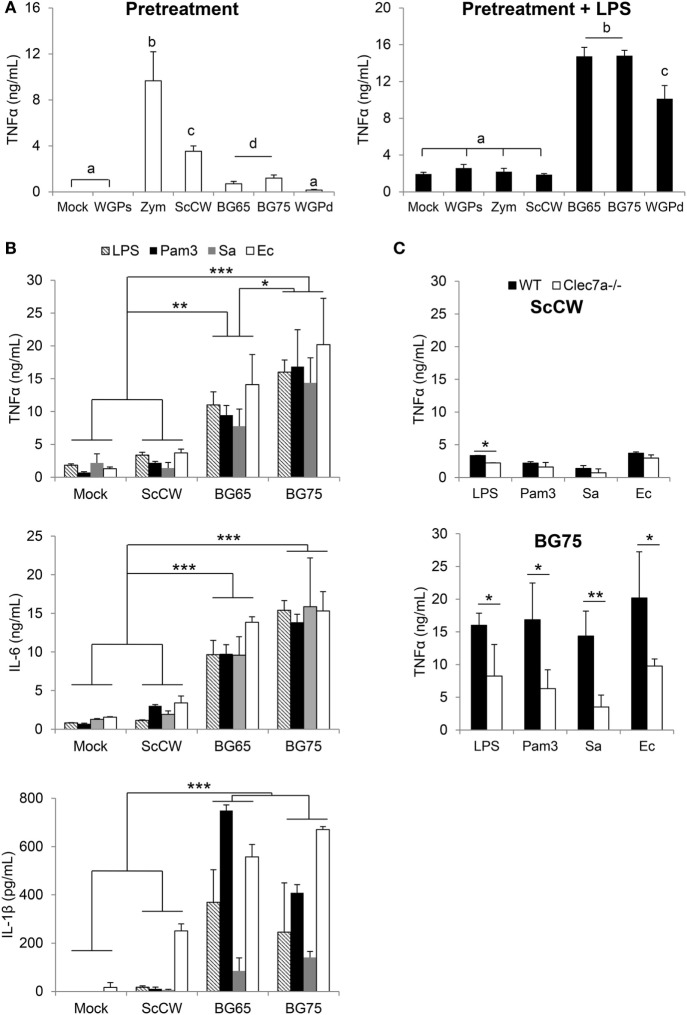
BG-enriched preparations of Saccharomyces cerevisiae cell wall (ScCW) prime the macrophage response predominantly via Dectin-1 upon toll-like lectin receptor (TLR) ligands or whole bacteria exposure. Wild-type (WT) thioglycollate-elicited peritoneal macrophages (A) and WT or Clec7a−/− bone marrow-derived macrophages from C57BL/6 mice (B,C) were stimulated with 100 µg/mL of crude (ScCW) or BG-enriched (BG65, BG75) compounds for 8 h. After incubation, cell culture supernatants were collected [panel (A) on the left, white bars] and stored at −20°C. Cells were then stimulated with 100 ng/mL of ultraPure lipopolysaccharide (LPS) for 16 h [panel (A) on the right: dark bars, (B) and (C)] or Pam3CSK4 (Pam3) [(B) and (C)]. For the stimulation with live bacteria, Staphylococcus aureus N305 or Escherichia coli P4 strains were used at MOI = 10 for 1 h, followed by 16 h incubation with cell culture medium supplemented with Gentamicin™ (B) and (C). At the end of the incubation, supernatants were collected and immediately stored at −20°C. TNFα, IL-6, and IL1β were quantified by ELISA. Data are expressed as the mean ± SD from three independent experiments performed in triplicate. In (A,C), a Student’s t-test was used to assess significance between conditions (*p < 0.05; **p < 0.01) and mean values not sharing the same letter in (A) are significantly different. In (B), a two-way ANOVA with Bonferroni post-tests was used to compare pretreatment conditions (*p < 0.05; **p < 0.01, ***p < 0.001).